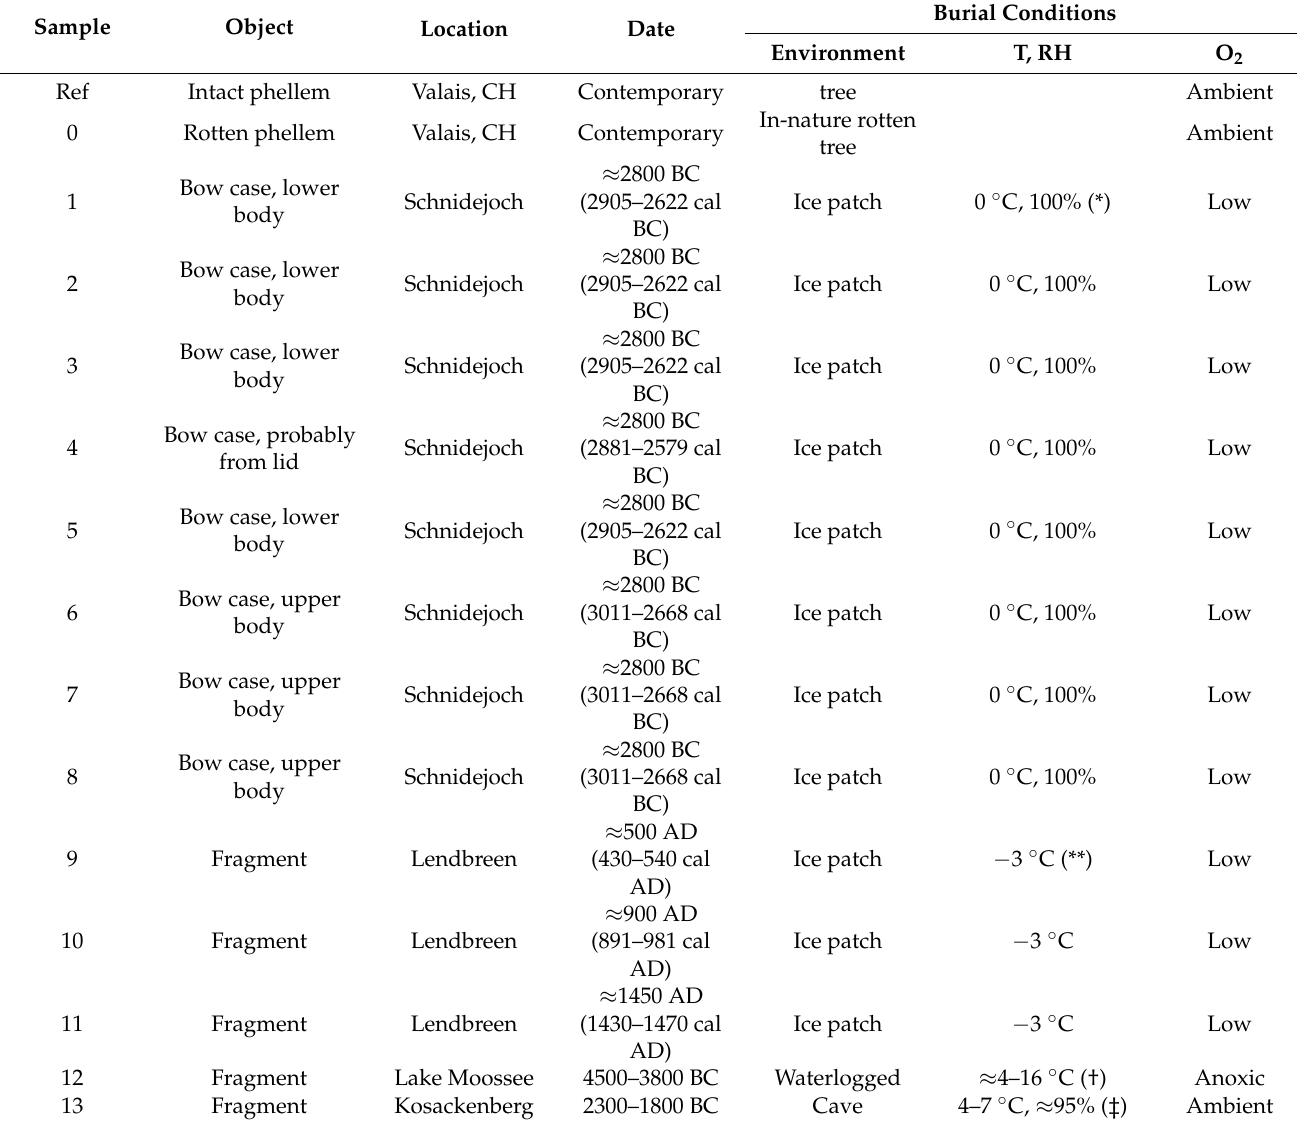
Table 1. Analysed samples and their location, dating and burial